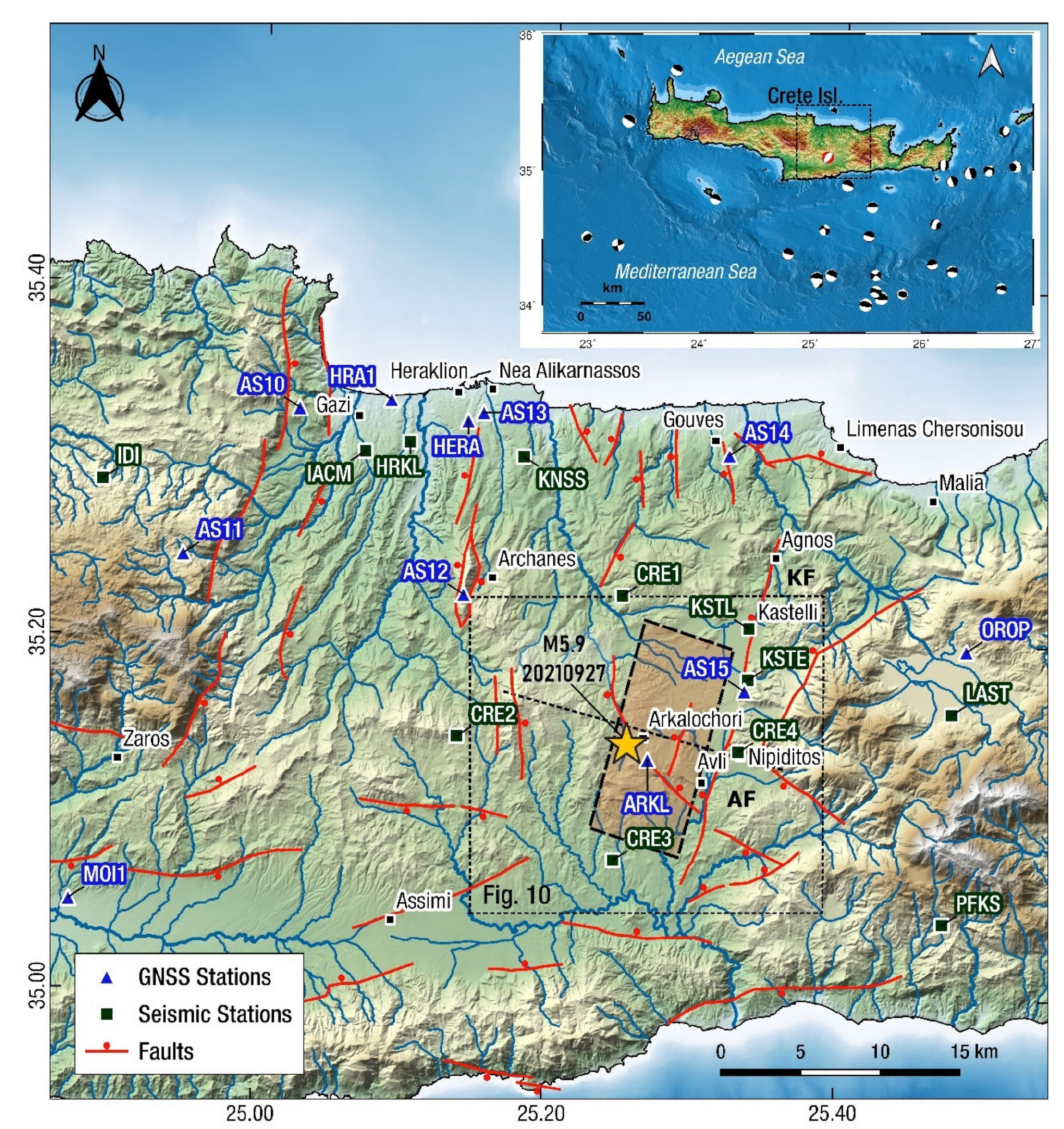
Figure 1. Shaded relief map of the 27 September 2021, Arkalochori Mw = 5.9 earthquake area in central Crete (Greece). Solid yellow star indicates the relocated mainshock epicentre (this study). Shaded rectangle indicates surface projection of the fault plane (this study). Blue triangles indicate GNSS stations. Black squares indicate seismic stations. Thin black box shows extent of Figures 9 and 10. Black dashed line indicates profile location shown in Figures 13 and 14. Red lines are active faults from the NOAFAULTs database https://doi.org/10.5281/zenodo.6326260 (accessed on 1 December 2021) and [27] with modifications; ticks indicate downthrown side. Inset box at upper right shows study area within Crete and focal mechanisms (1976–2021) from the GCMT database